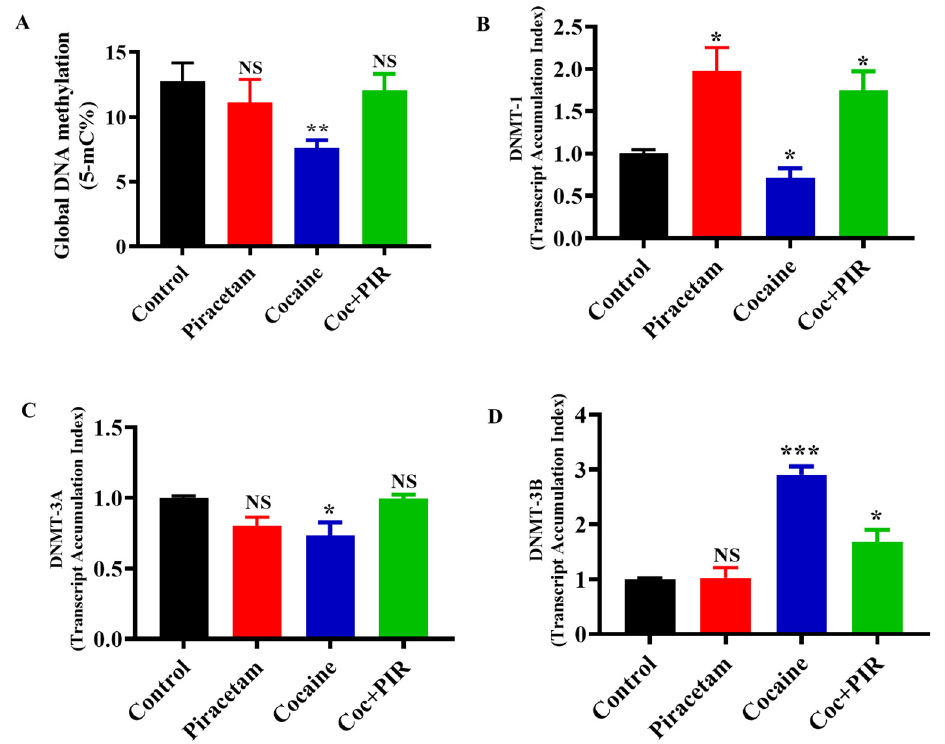
Figure 1. Piracetam reversed the impact of cocaine on global DNA methylation (5-mc) and DNA methyltransferases’ (DNMTs’) gene expression. Human primary astrocytes (2 × 10 6 cells / mL) were exposed to cocaine (1 µ M) and / or piracetam (10 µ M) for 24 h. Total cellular DNA were used to determine the global DNA methylation (5-mC) by ELISA ( A ) and the total RNA were analysed ( B ) DNMT-1, ( C ) DNMT-3A and ( D ) DNMT-3B mRNA expression by qRT-PCR. The housekeeping gene β -actin